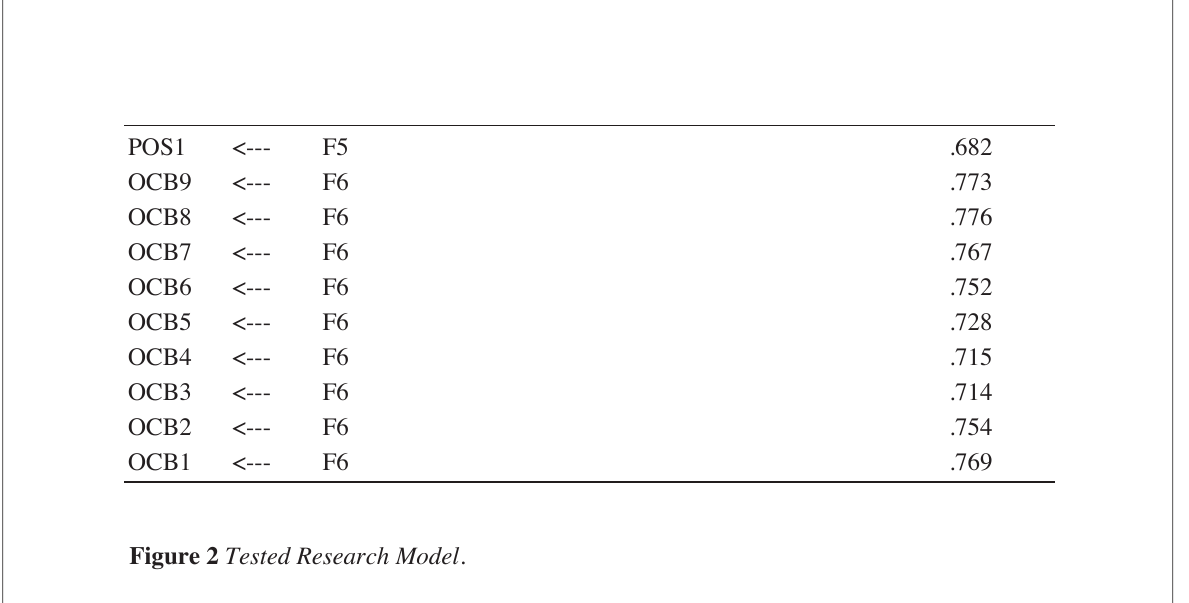
Figure 2 Tested Research